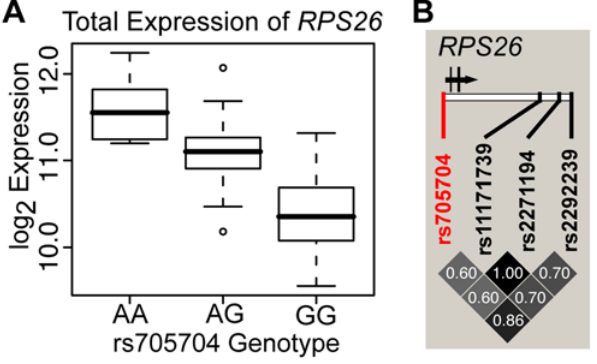
Figure 1. Total expression analysis. Genotypic associations with total expression level. (A) Boxplot of RPS26 expression according to genotype at the promoter SNP rs705704 (p=1.2 6 10 2 20 ). The boxes define the interquartile range and the thick line is the median. Open dots are possible outliers. (B) Haploview linkage disequilibrium (LD) plot of the RPS26 region. The SNP rs705704 is 274 bp upstream of the RPS26 CEU population. rs705704 (red) is partially linked to three SNPs (black) previously shown to associate with RPS26 expression levels